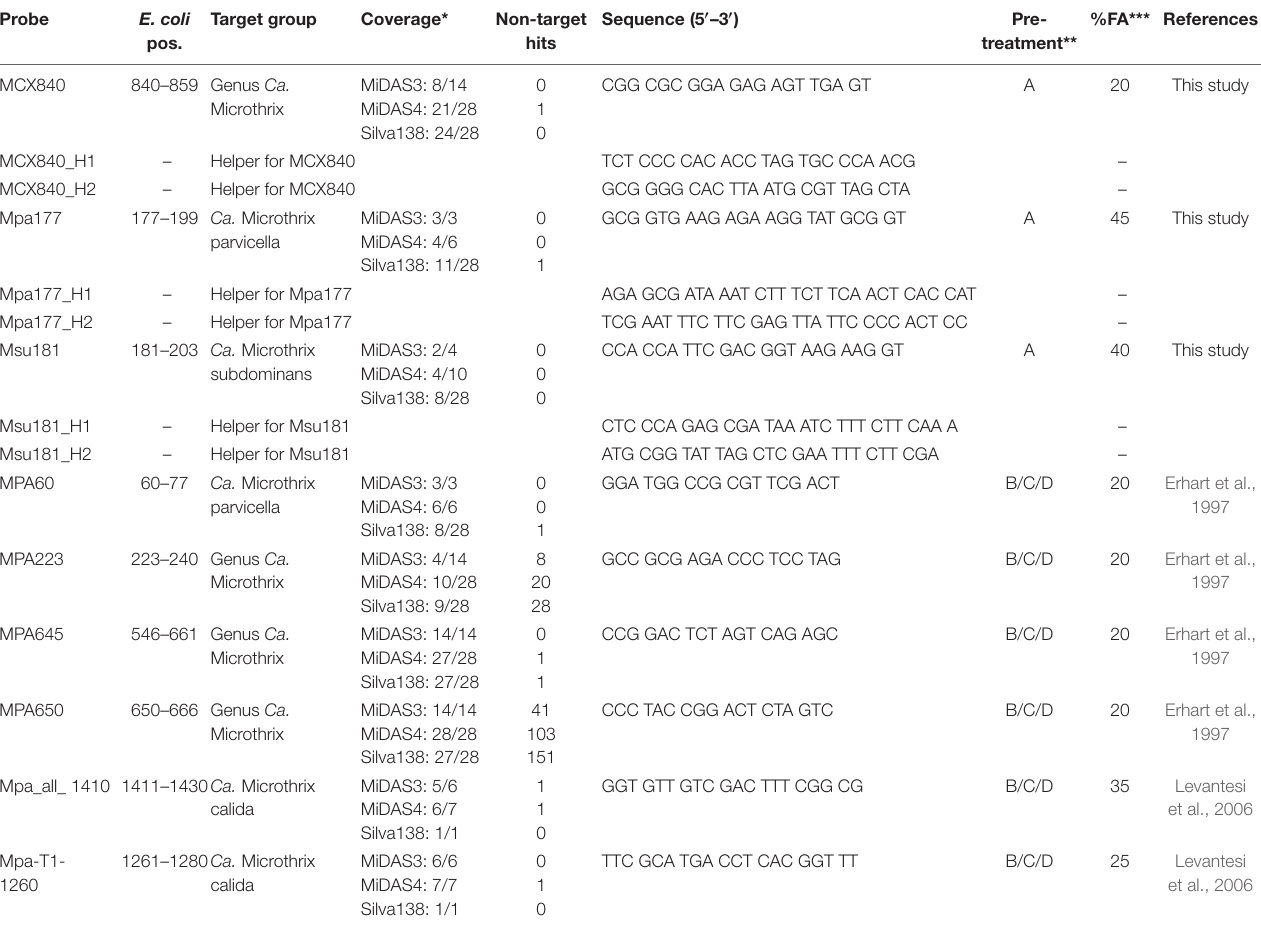
TABLE 1 | Overview of the existing and new FISH probes targeting Ca. Microthrix. Probe E. coli